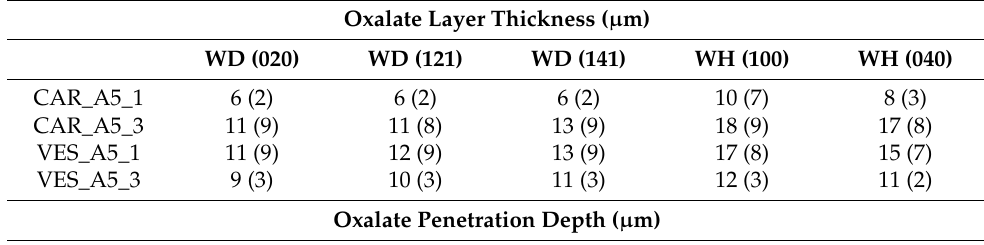
Table 1. Oxalate layer thickness and penetration depth for the Carrara marble (CAR) and Veselje (21 lines) with standard deviations (1 s) in parentheses. WD = weddellite; WH = whewellite.